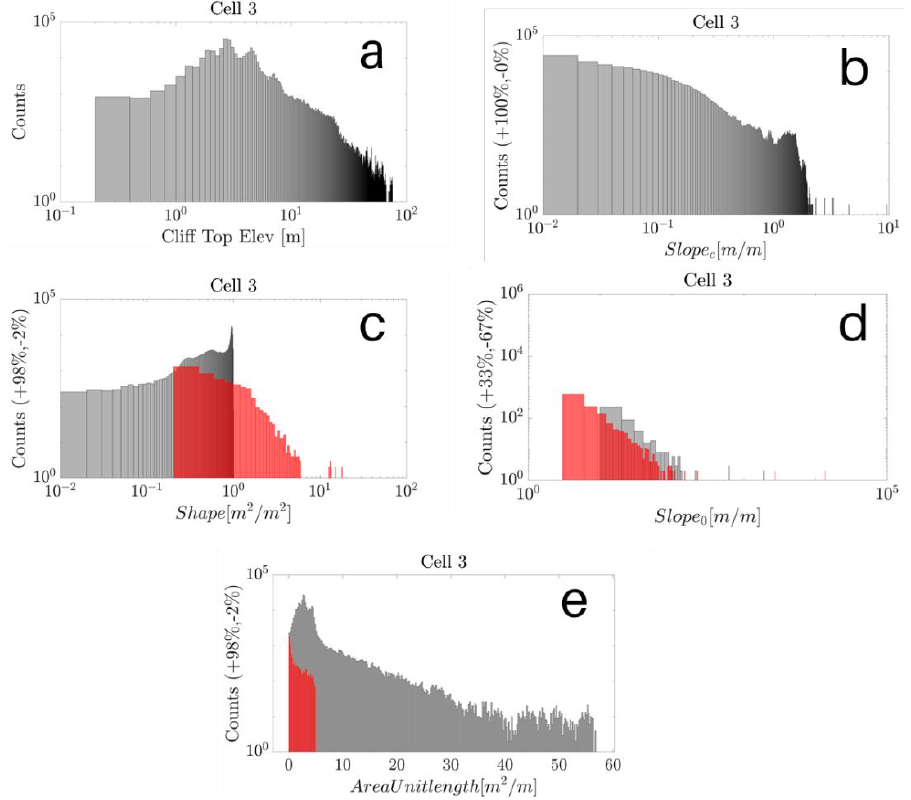
Figure 14. Example of the regional statistics that we extracted for the 22 regions into which we divided the GB coastline. As an example, we show here the stats for region “Cell 3”, and all other regions are in Supplementary Materials; panels show the counts per region of the cliff top elevation ( a ), slope of cliff face ( b ), shape of the inland topography ( c ), inland slope ( d ) and area per unit length ( e ). These geometrical attributes were calculated as shown in Figure 14. Region area is shown in Figure 13.